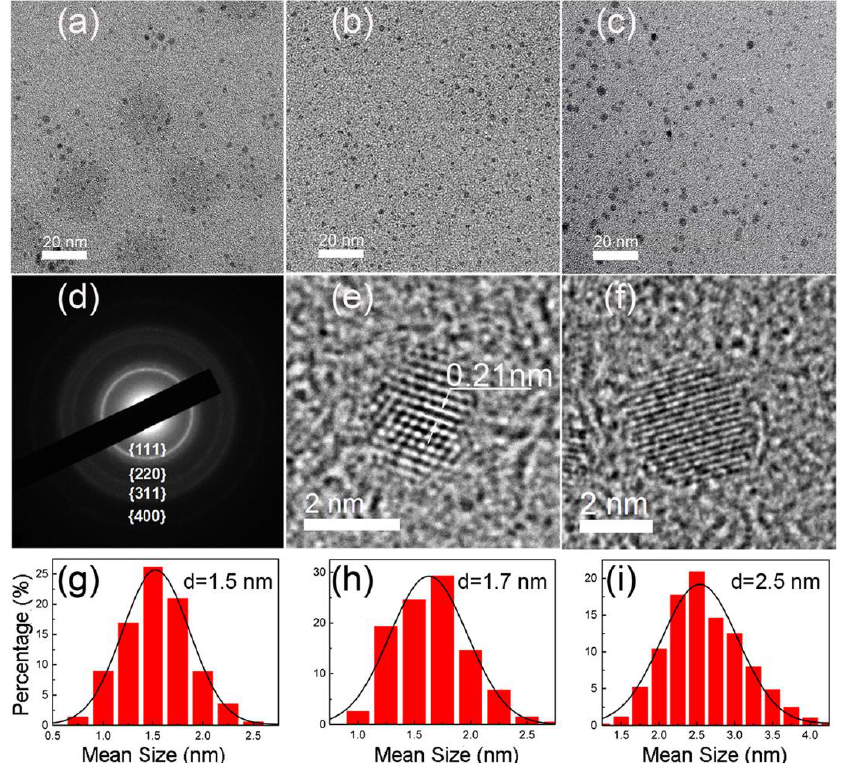
Figure 31. Effect of laser fluence on the production of CDs: ( a ) 150 J/cm 2 , ( b ) 350 J/cm 2 , ( c ) 750 J/cm 2 , ( g – i ) size distribution, respectively, ( d ) SAED of c, ( e ) HRTEM of a, ( f ) HRTEM of c. Reprinted with permission from Ref. [104]. 2015, AIP Publishing .